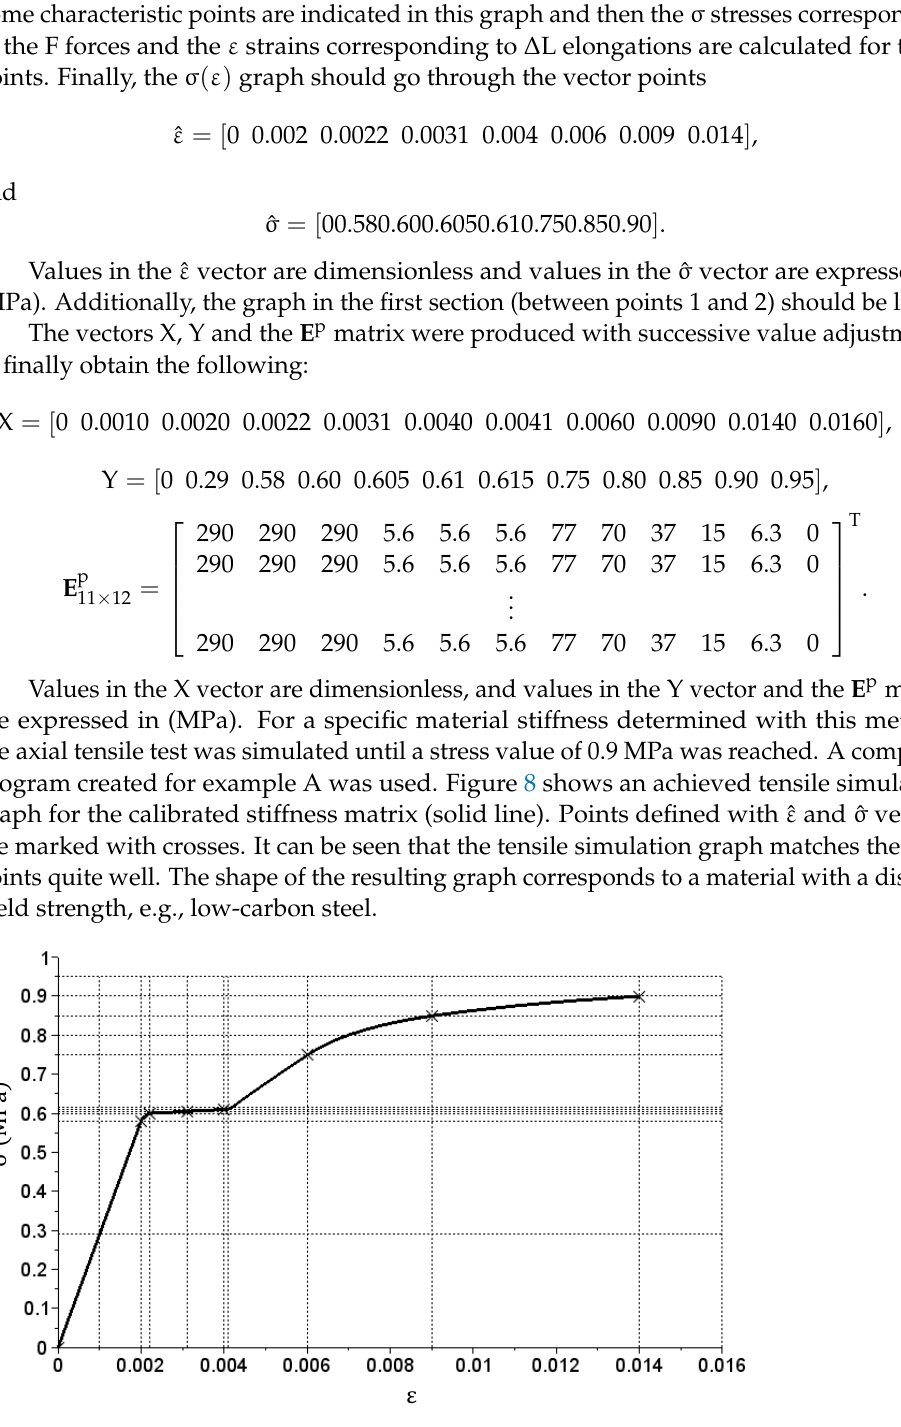
Figure 8. σ ( ε ) relation graph achieved for the calibrated stiffness matrix in case Figure 8. σ(ε) relation graph achieved for the calibrated stiffness matrix in case 1.